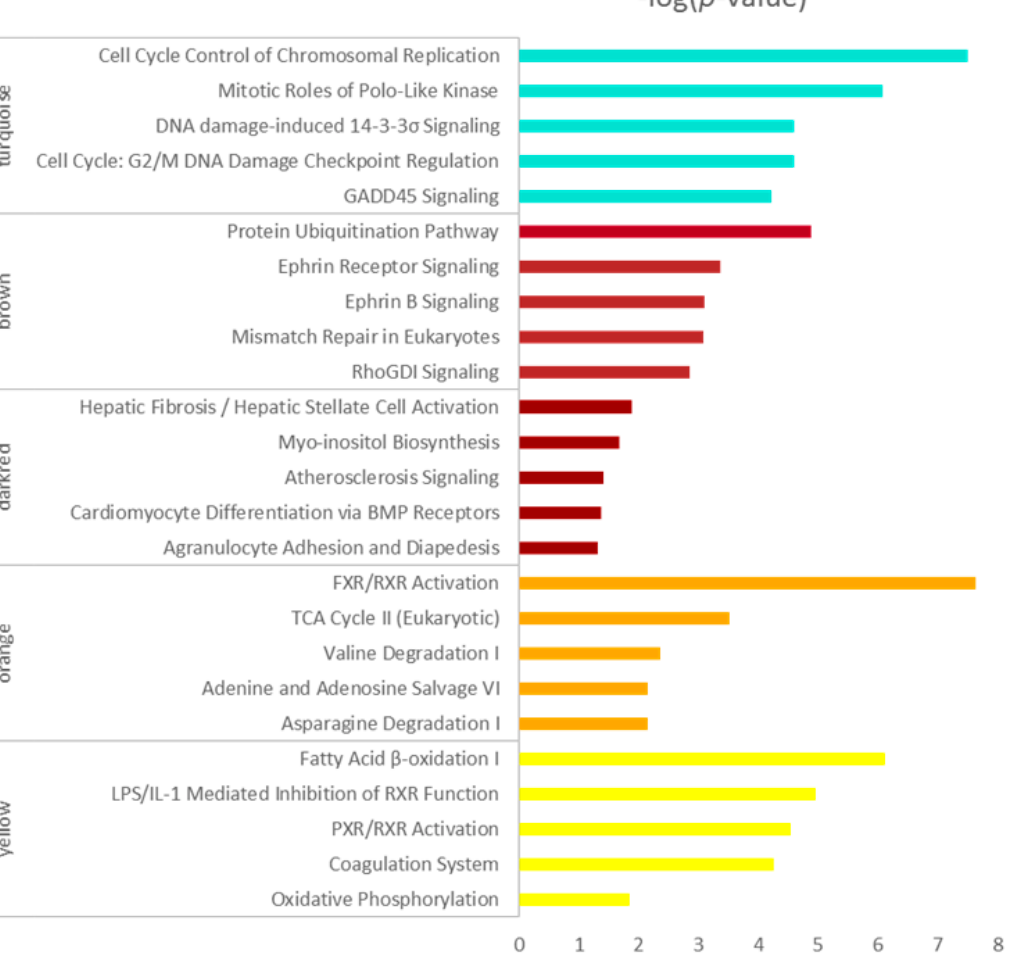
Figure 4. Top 5 enrichment results of canonical pathway analysis by ingenuity pathway analysis (IPA) for co-expressed genes in turquoise, brown, darkred, orange and yellow modules. Pathway names are shown on the left, and the bars on the right represent the − log( p value) of the corresponding pathway. The different colors of the bars are in accordance with the corresponding modules.